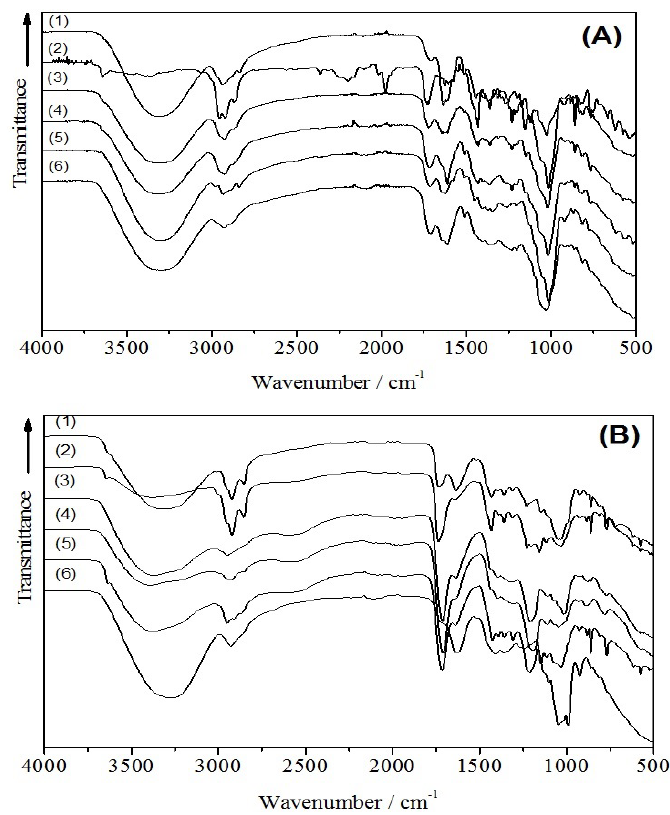
Figure 3. FTIR spectra of various citrus species extracted from the peels ( A ) and the pulps ( B ). The number indicates the citrus species in the following order: (1) calung, (2) makin, (3) mentui, (4) jeruk nipis, (5) jeruk purut, (6) kruet mameh. The general assignments of infrared spectra are the following: The infrared band at 3500–3200 cm − 1 could be assigned to O–H stretching vibration of either macromolecular compounds or absorbed water. The infrared band at 3000–2800 cm −1 was attributed to C–H stretching vibration of methyl,